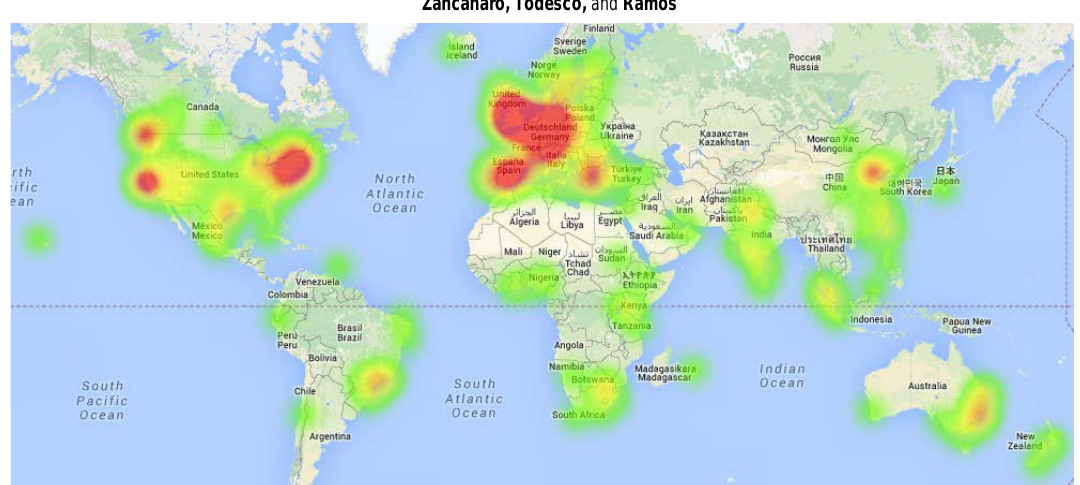
Figure 3. World map showing the main locations of OER research.